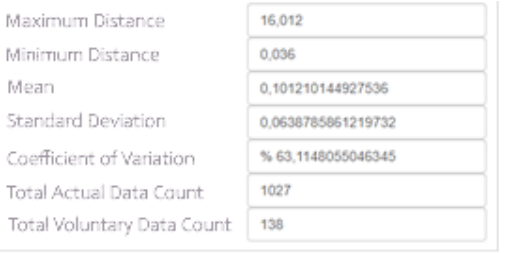
Figure 7. Mobile application interfaces. Figure 8. Evaluation